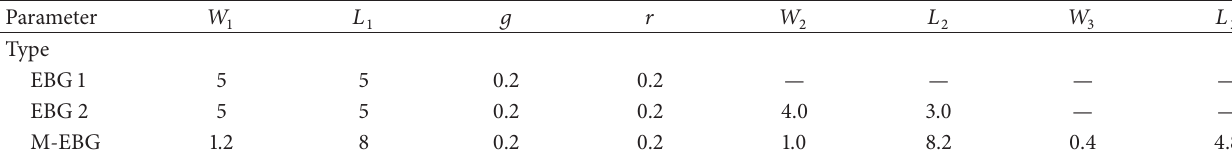
Figure 3: Comparison of the simulated return loss among EBG 1, EBG 2, and the proposed M-EBG. Table 1: Dimension parameters of EBG 1, EBG 2, and M-EBG (unit: